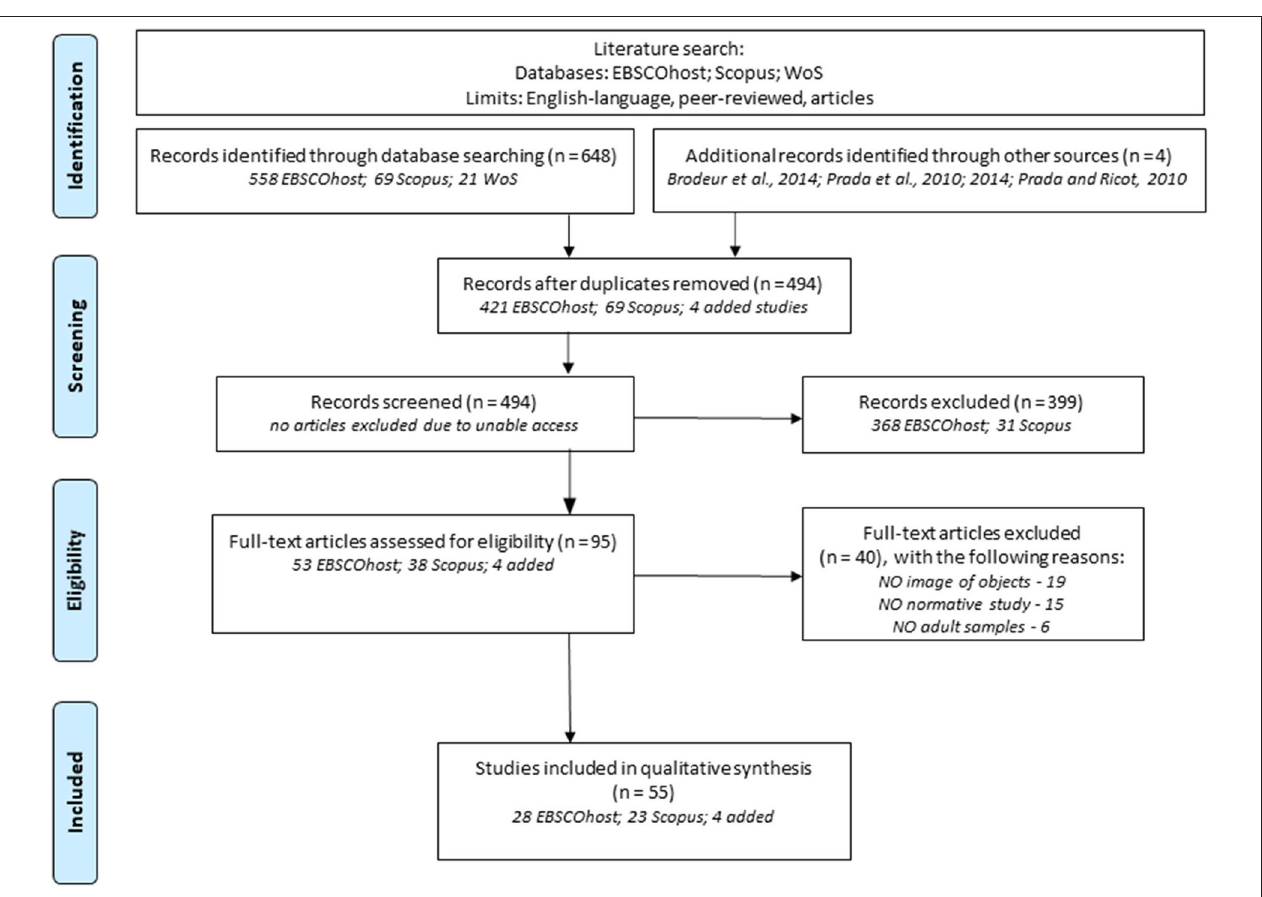
FIGURE 1 | Flow diagram of studies’ selection process, using the PRISMA method (adapted from Liberati et al.,